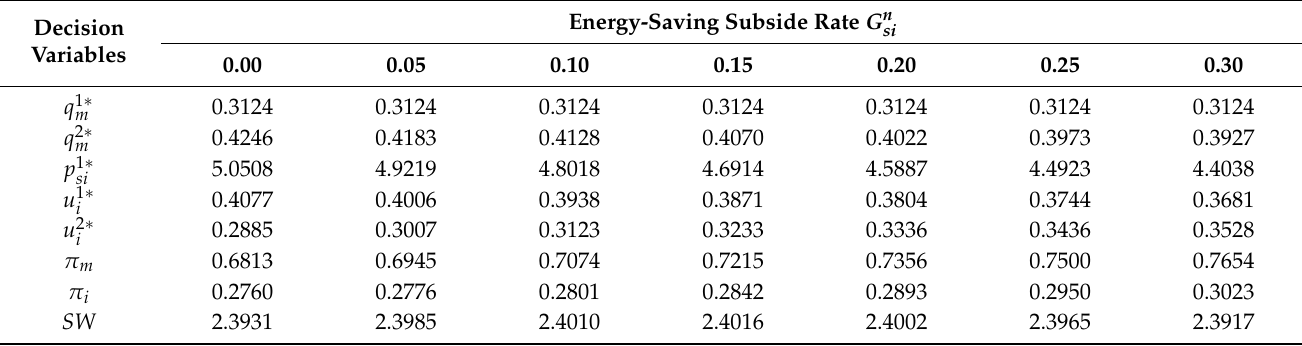
Table 3. The effect of G n on SCNE when the demand scales for HEEP and LEEP are equal. si